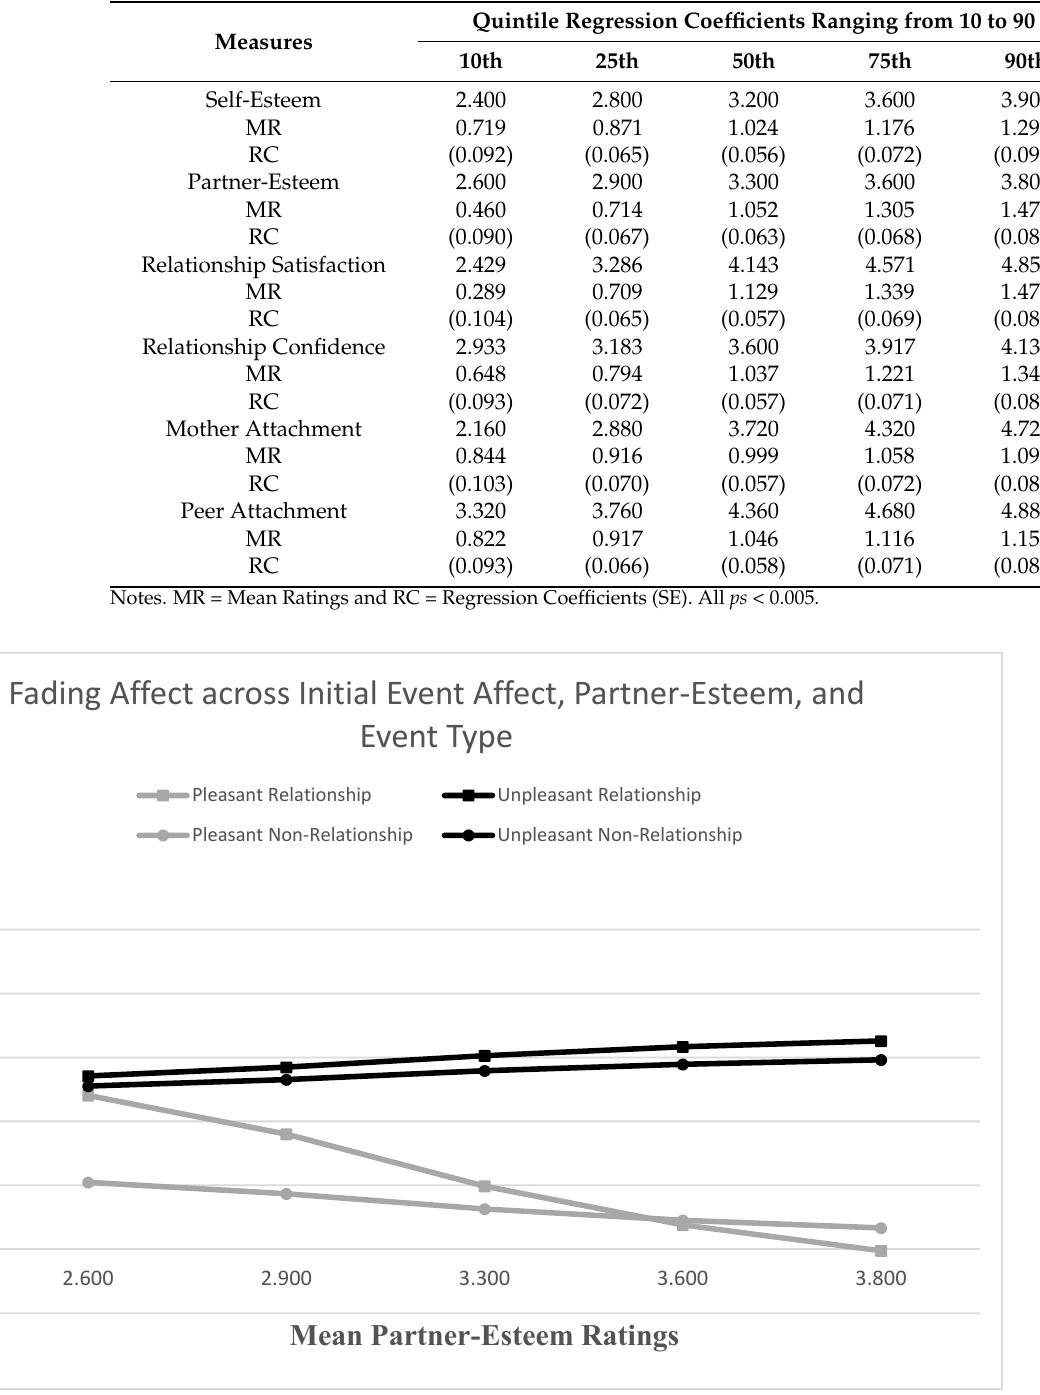
Figure 9. Fading affect for pleasant and unpleasant relationship and non ‐ relationship events across quintile levels (10th through 90th) of partner ‐ esteem. Table 2. Fading Affect Bias Regression Coefficients (SE) for Relationship Events and Non ‐ Relation ‐ ship Events across Quintiles (Mean Rating) of Partner ‐ Esteem Ratings (large positive coefficients represent large FAB).